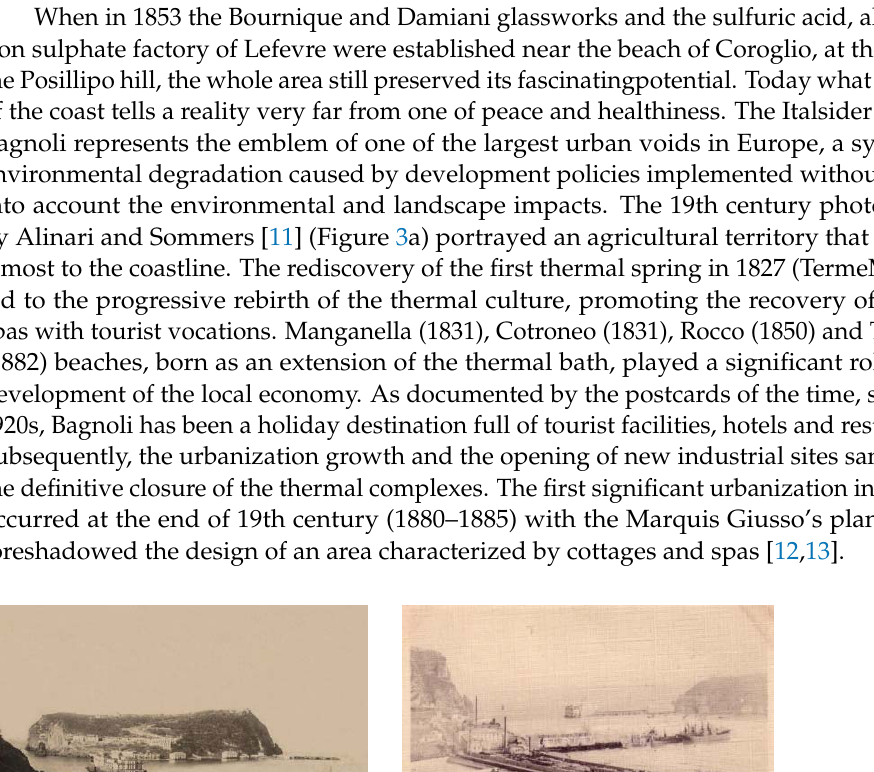
Figure 2. Lamont Young Project (1883–1888). GIS cartography realized by at the Laboratory on the Landscape of the CNR/ IRET implementing orto-imagine 2007 of the Province of Naples, Extract n° 8 of the Cartography of 1817–1823. Graphical elaboration by Marina Russo.